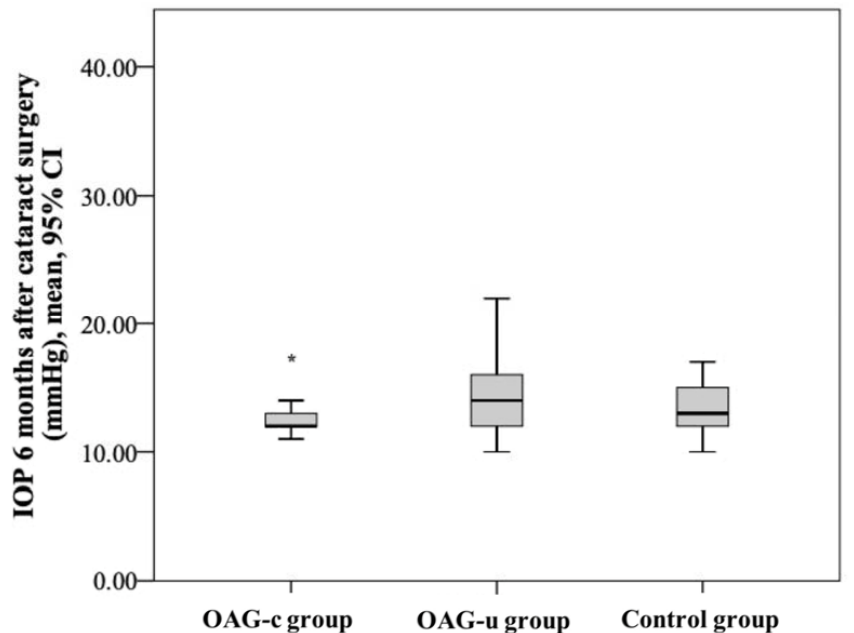
Figure 4. IOP 6 months after cataract surgery in all groups. Asterisk (*) marks statistically significantly lower IOP in the OAG c group than in the OAG u group ( p < 0.001). IOP reduction in the control group was statistically significantly lower than in the OAG c group ( p = 0.001). IOP reduction in the OAG u group was statistically significantly higher than in the OAG c group ( p = 0.018). IOP reduction in the OAG u group was statisti- cally significantly higher than in the control group ( p < 0.001) (Figure 5).